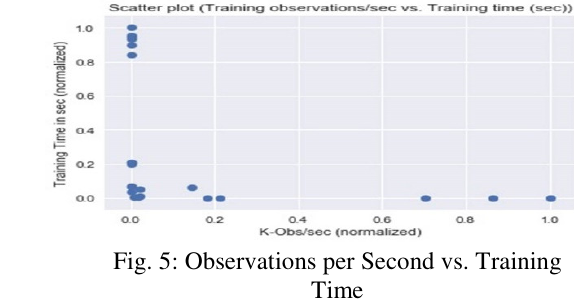
Fig. 5: Observations per Second vs. Training